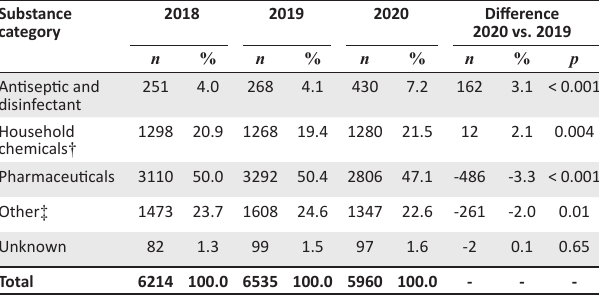
TABLE 2: Substance categories of poisoning exposure calls received by the Poisons Information Helpline of the Western Cape in the first six months of the COVID-19 pandemic and similar periods during 2018 and 2019. Substance